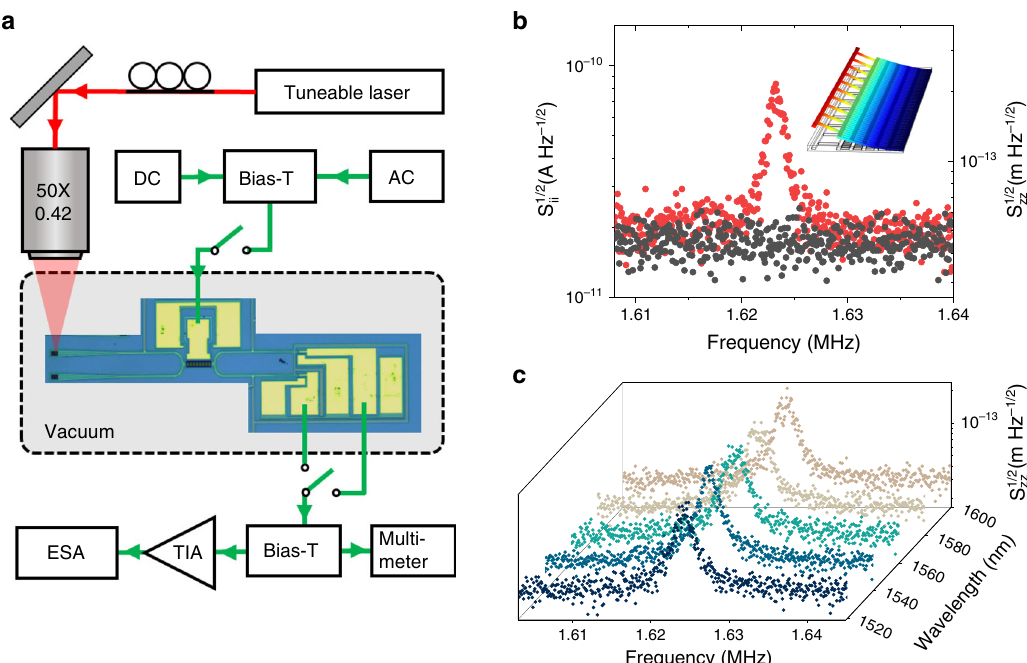
Fig. 5 Experimental set-up and the measurement of the thermal noise. a Schematics of the thermal noise measurement setup. b Photocurrent (left axis) and displacement (right axis) spectral density, measured by the ESA with (red circles) and without (black circles) laser ( λ = 1540 nm, on-chip power 0.3 mW, actuator bias voltage 1.5 V), showing a peak corresponding to the Brownian motion of the fundamental mechanical mode. Inset: Calculated mode shape of fundamental mechanical mode. c Brownian motion measured at different